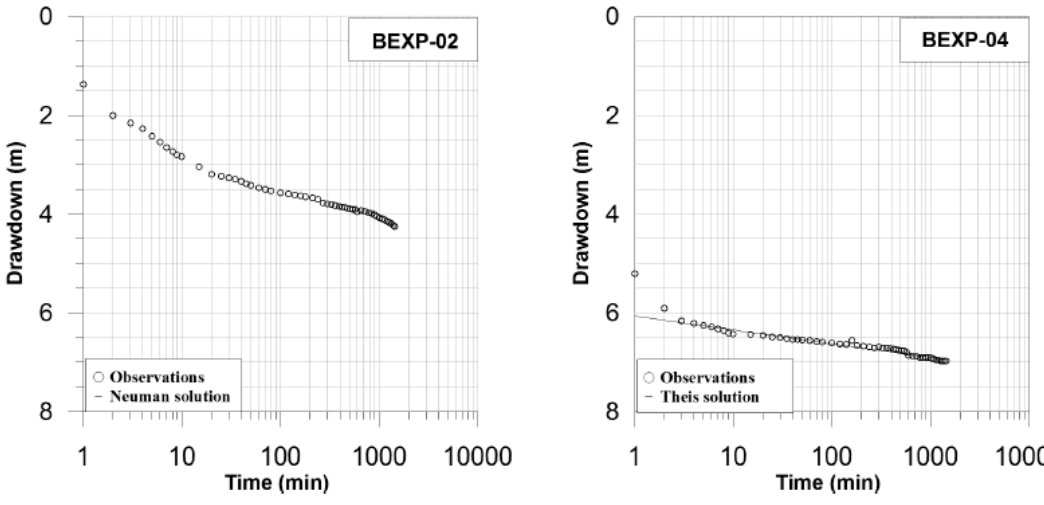
Figure 4. Observed drawdown against time and interpretation of constant rate pumping tests.